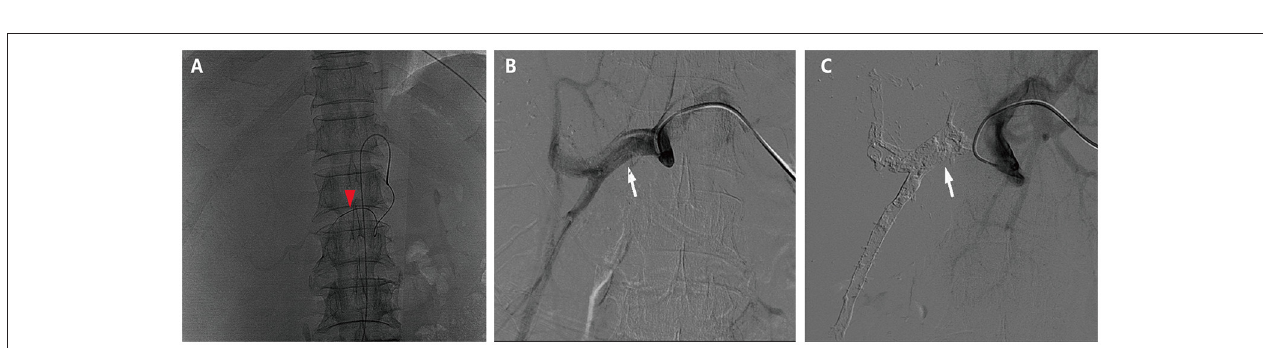
FIGURE 1 | Computed tomography (CT) scans and three-dimensional reconstruction at initial diagnosis. (A) A large lesion (the red arrow head) in the right lobe of the liver, measuring about 19.3 × 14.6 × 13.2cm. The middle hepatic vein (the black arrow) ran almost along the edge of the lesion. (B) The future liver remnant (FLR, the light green area), followed right hemi-hepatectomy divided by standard liver volume (SLV), was 51.47%, which was well-tolerated for hepatectomy, although the surgical margin was nearly zero. (C) If extended right hemi-hepatectomy were to be performed, the FLR (the yellow area)/SLV would be 25.78%, with an extremely high risk of post-hepatectomy liver failure.